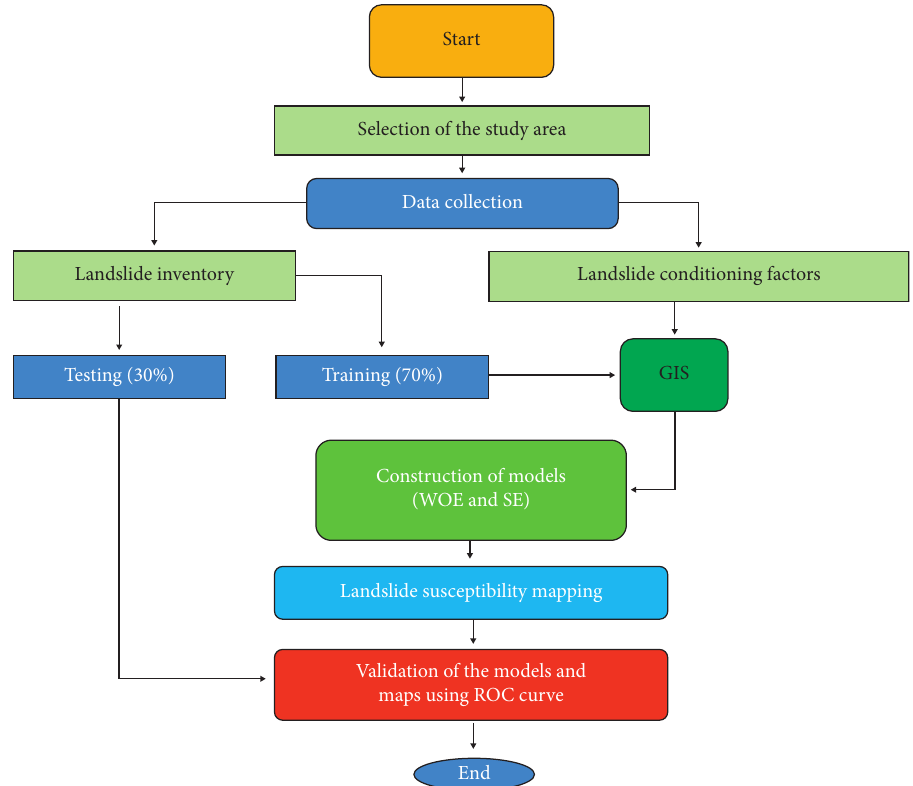
Figure 3: Methodological flowchart of the present